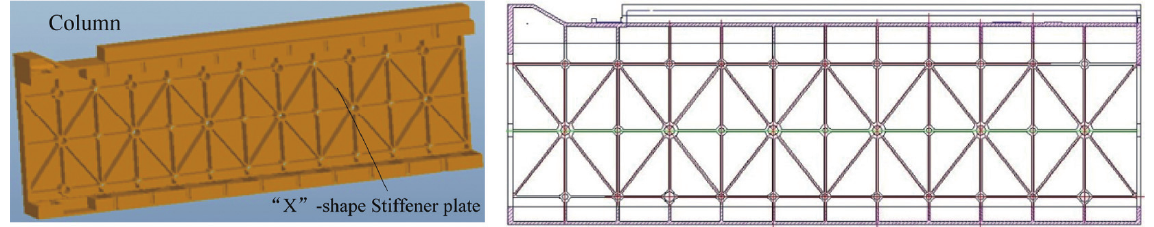
Fig. 4. The original column. (a) Stiffener plate structure of original column; (b) 2-D drawing of original stiffener